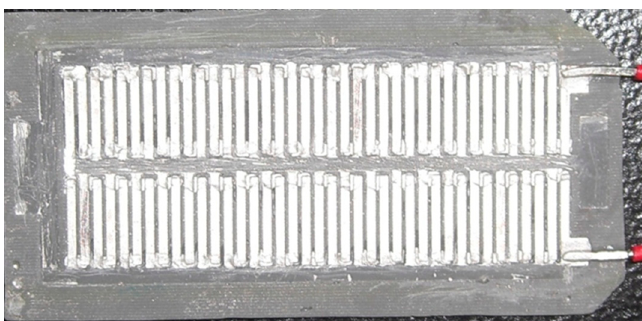
Figure 6. An image of the flexible thermoelectric generator.